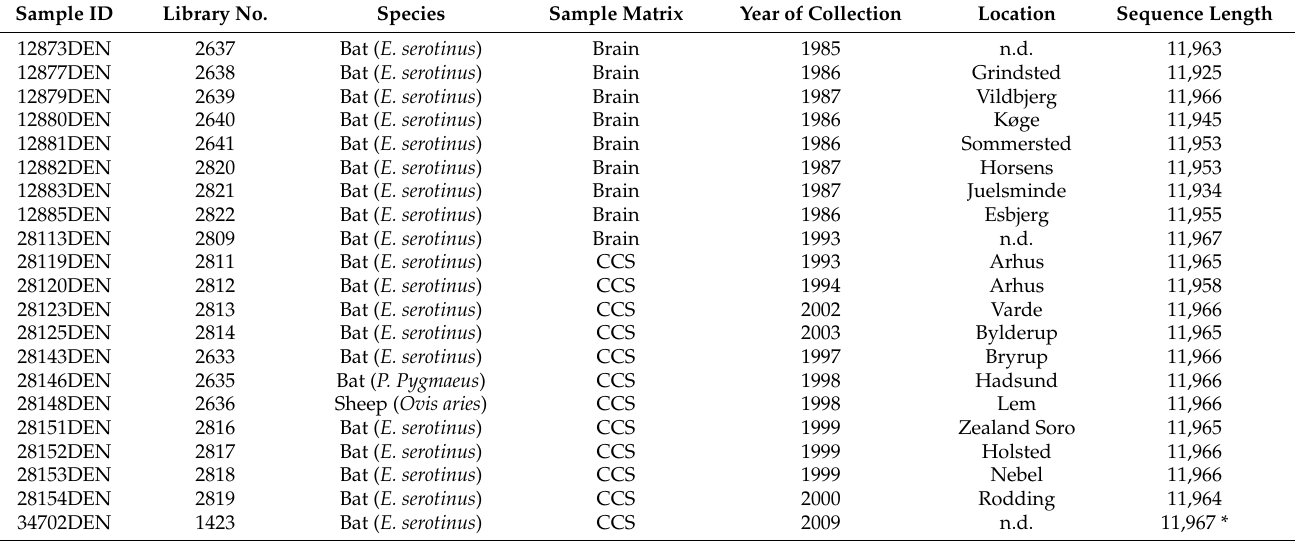
Table 1. Overview of the investigated Danish